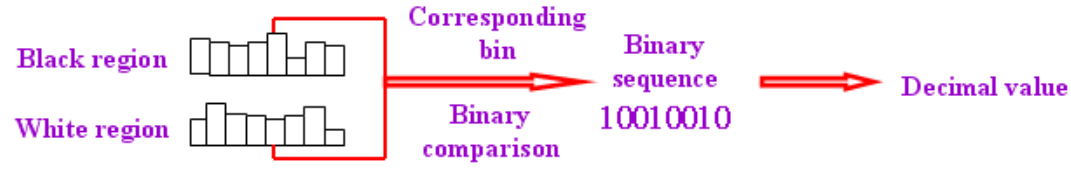
Figure 9. The local feature extraction and encoding.